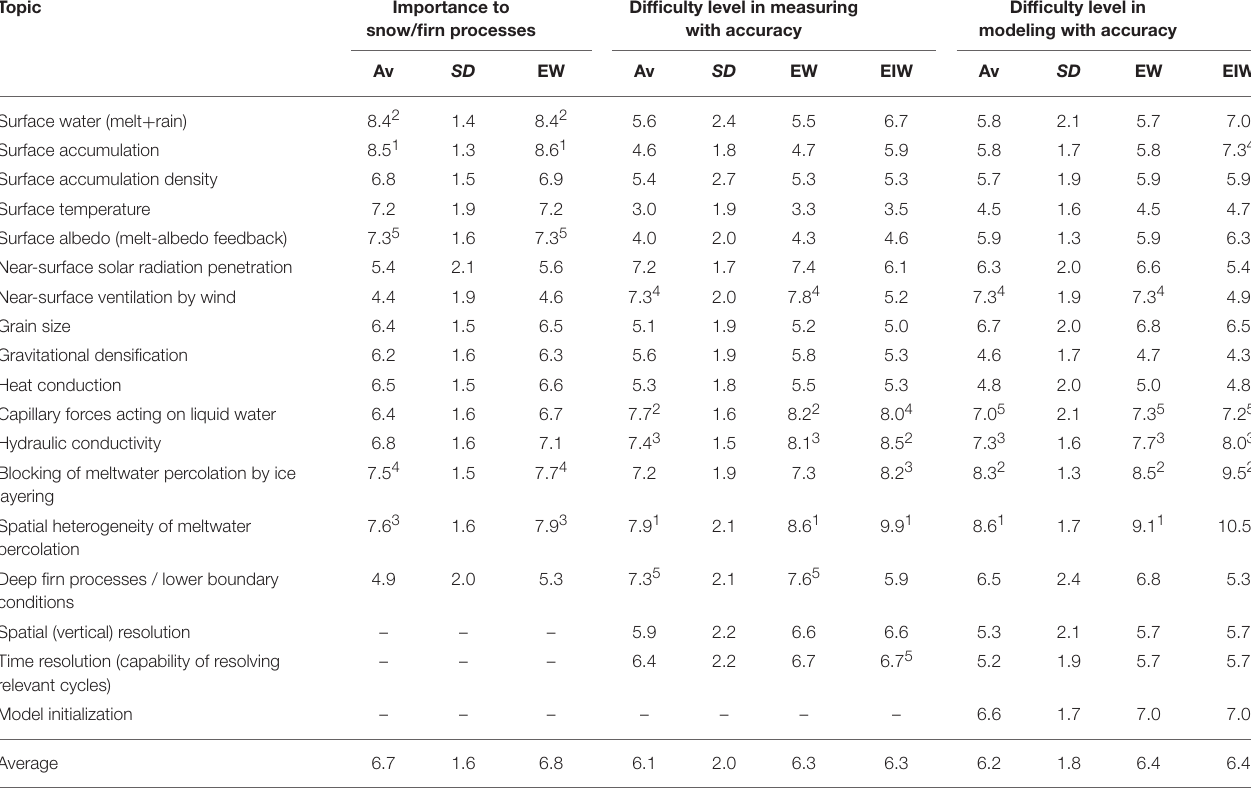
TABLE 1 | Expert judgment assessment of snow/firn processes and properties relevant to retention. Topic Importance to snow/firn